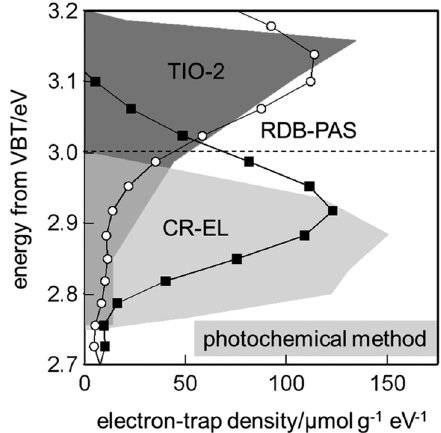
Figure 2. Comparison of energy-resolved distribution of electron traps (ERDT) patterns measured using the photochemical method shown by the grey patterns [60], and reversed double-beam photoacoustic spectroscopy (RDB-PAS), shown by the plots [56], for representative anatase (TIO − 2 ; 18 m 2 g − 1 ) and rutile (7 m 2 g − 1 ) samples. The top line, at 3.2 eV, and the dashed line show the conduction bands (CB) edge positions of anatase and rutile estimated by the reported bandgaps at 3.2 and 3.0 eV, respectively. Reprinted from reference [56], an open access article under conditions of the Creative Commons Attribution (CC BY)